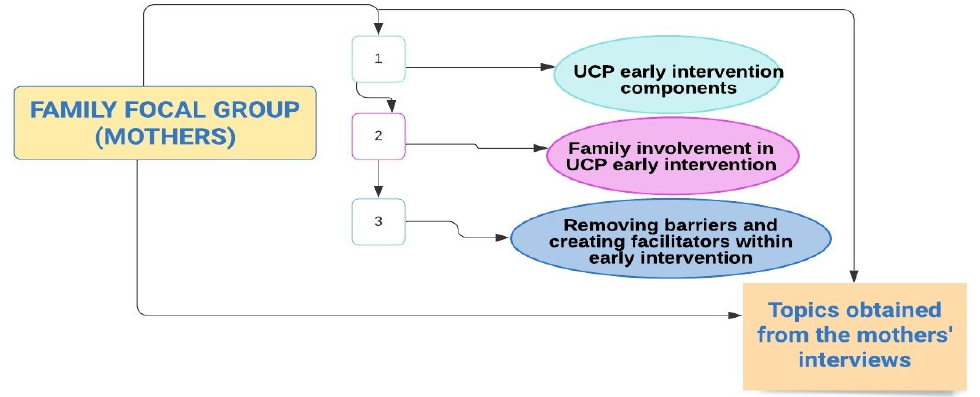
Figure 1. Topics obtained from mothers’